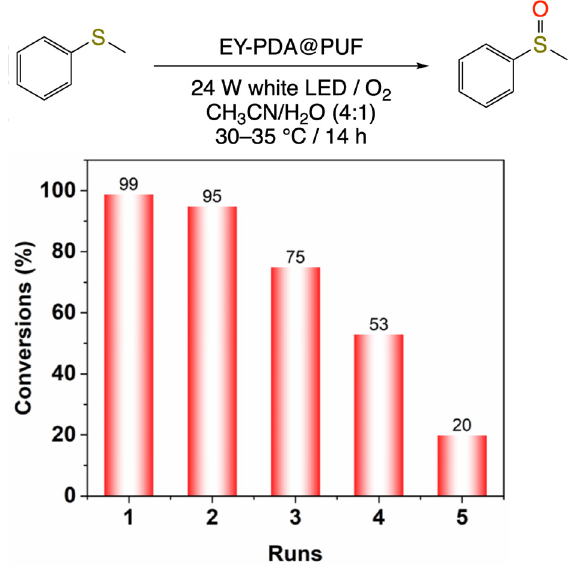
Figure 11. GC conversions measured over five successive runs of thioanisole oxidation photocatalyzed by a single sample of EY-PDA@PUF. Reaction conditions: thioanisole (0.5 mmol), EY-PDA@PUF (2.5 cm × 2.5 cm × 2.5 cm), CH 3 CN/H 2 O (4:1) (20 mL), 24 W white LED, O 2 balloon, 30–35 °C due to LED light heat, 1000 rpm.